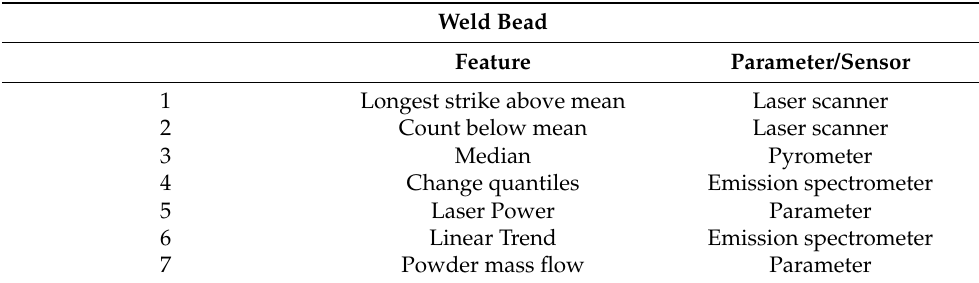
Table 2. Relevant features for weld bead